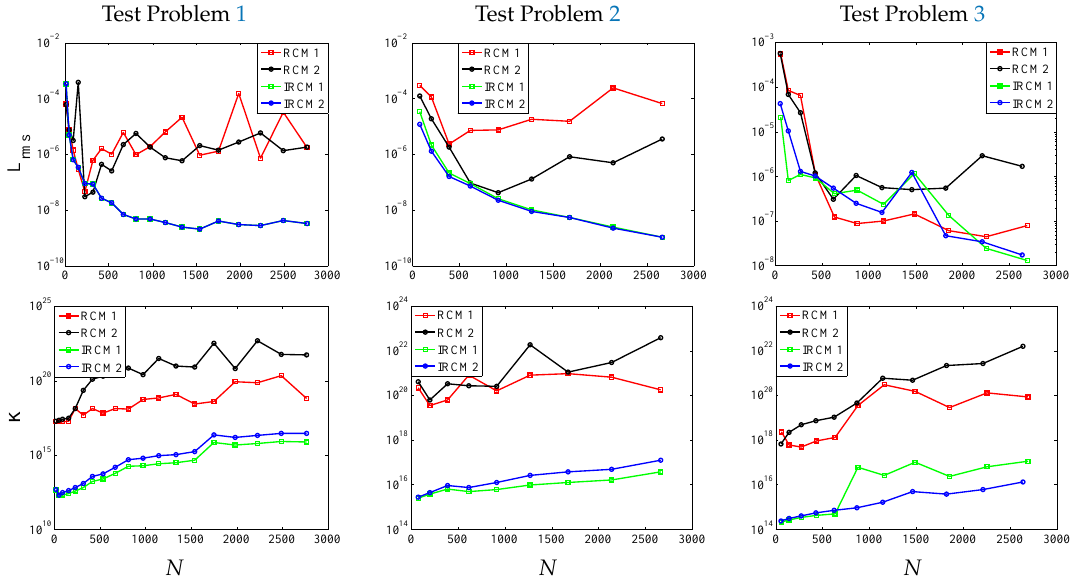
Figure 12. Test Problems 1–3, accuracy and κ versus N . (cid:101) = 150, (cid:101) o = 2, and γ =